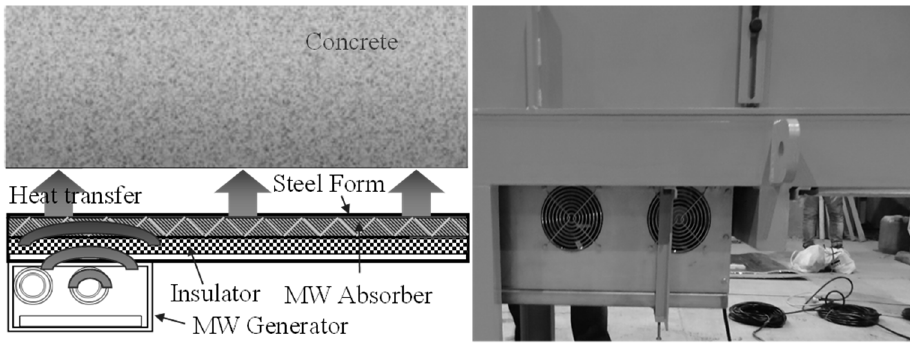
Figure 2. Heating of a steel form by microwaves (MWs).